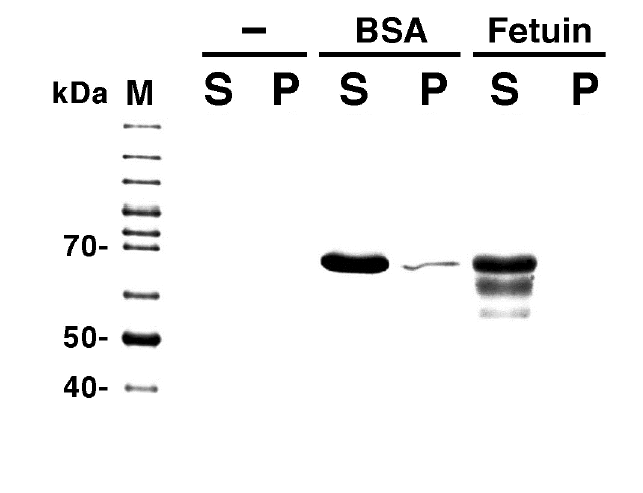
Figure 5. Cosedimentation assays of proteins with liposomes. ‘ − ’, ‘BSA’, and ‘Fetuin’ indicate the protein assayed (‘ − ’ indicates that a solution containing liposomes made from PC and PG (1:1, mol/mol) was centrifuged in the absence of protein). ‘M’, ‘S’ and ‘P’ indicate molecular weight markers, the supernatants and pellets of the centrifuged samples, respectively. All phospholipids used were obtained from native sources. HEPES-buffer alone or buffer containing 2.0 mg/mL BSA or 0.2 mg/mL fetuin was used for swelling